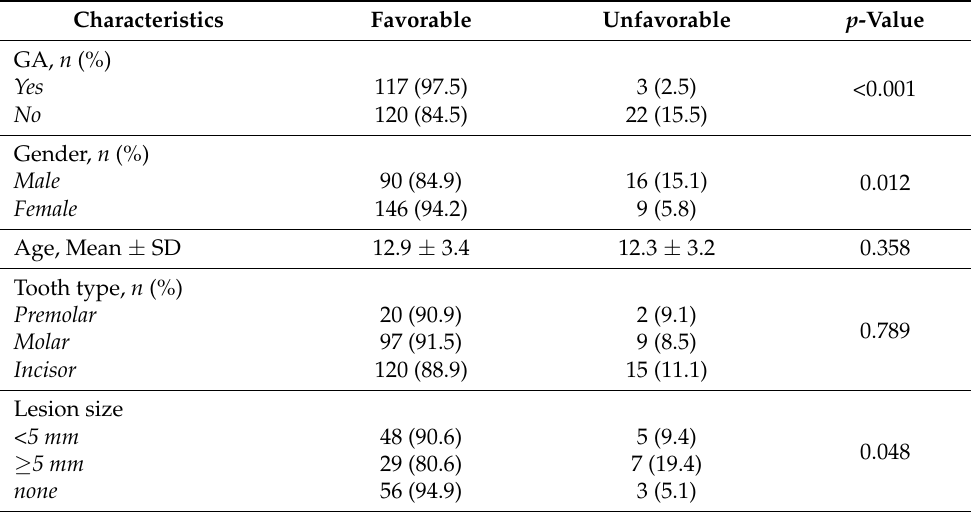
Table 2. Associations between parameters and outcome status.